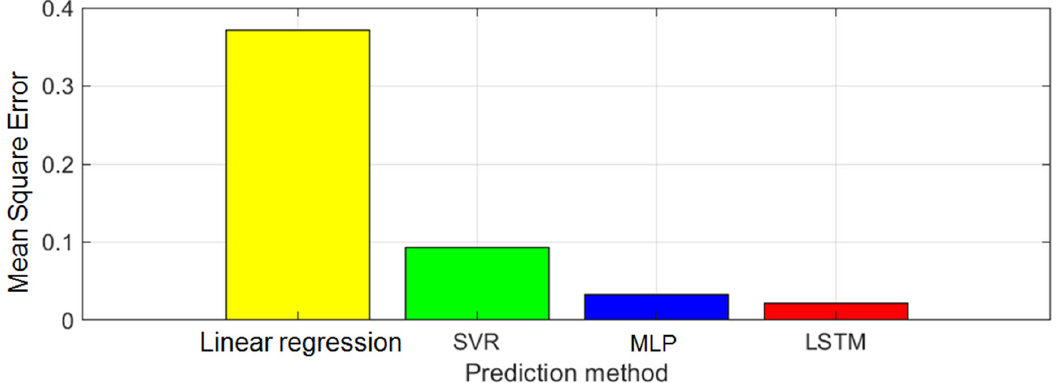
Figure 8. Comparison of four modeling error.